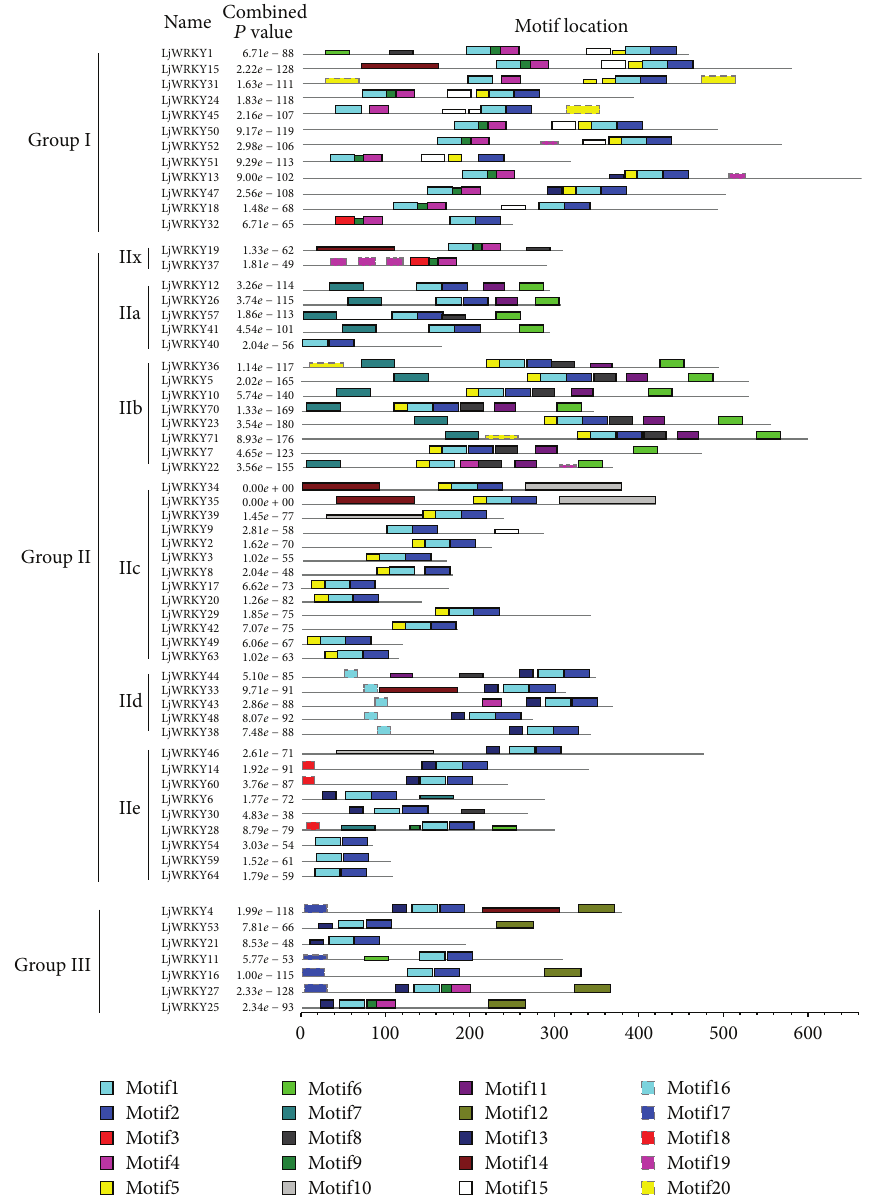
Figure 5: Distribution of 20 predicted conserved motifs in Lotus japonicus WRKY proteins. Motifs of Lotus japonicus WRKY proteins were identified by MEME program. The conserved amino acid sequences and length of each motif are shown in Table